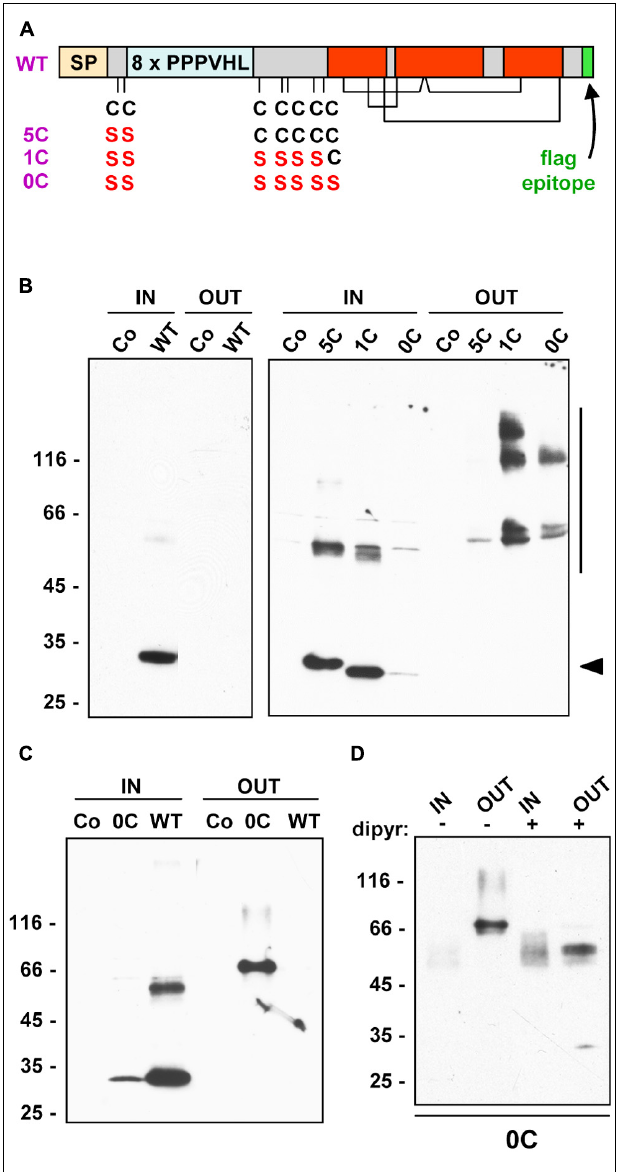
FIGURE 1 | Synthesis and secretion of γ -zein constructs. (A) Schematic drawing of the different protein constructs, in which the following features are indicated: signal peptide (orange, SP); Cys residues in the N-terminal region and their substitutions with Ser in the mutated forms; repeated domain (light blue, 8 × PPPVHL); 2S albumin homologous domains (red), with the four putative intrachain disufide bonds; added flag epitope (green). (B,C) Tobacco protoplasts were transfected with plasmid containing the indicated γ -zein constructs or with empty plasmid as control (Co) and incubated for 24 h. Protoplasts (IN) or incubation media (OUT) were then homogenated in the presence of 2ME. Aliquots corresponding to equal number of protoplasts or the corresponding incubation medium were analyzed by SDS-PAGE in reducing conditions and protein blot with anti-flag antiserum. (D) Protoplasts transfected with plasmid encoding 0C- γ -zein were incubated for 24 h in the presence ( + ) or absence ( − ) of 0.25 mM 2,2 (cid:2) -dipyridyl (dipyr). Proteins were then analyzed as in (B) . In (B) , the positions of monomers (arrowhead) and polymers (verical bar) are indicated at right. In (B–D) , numbers at left indicate the positions of molecular mass markers, in